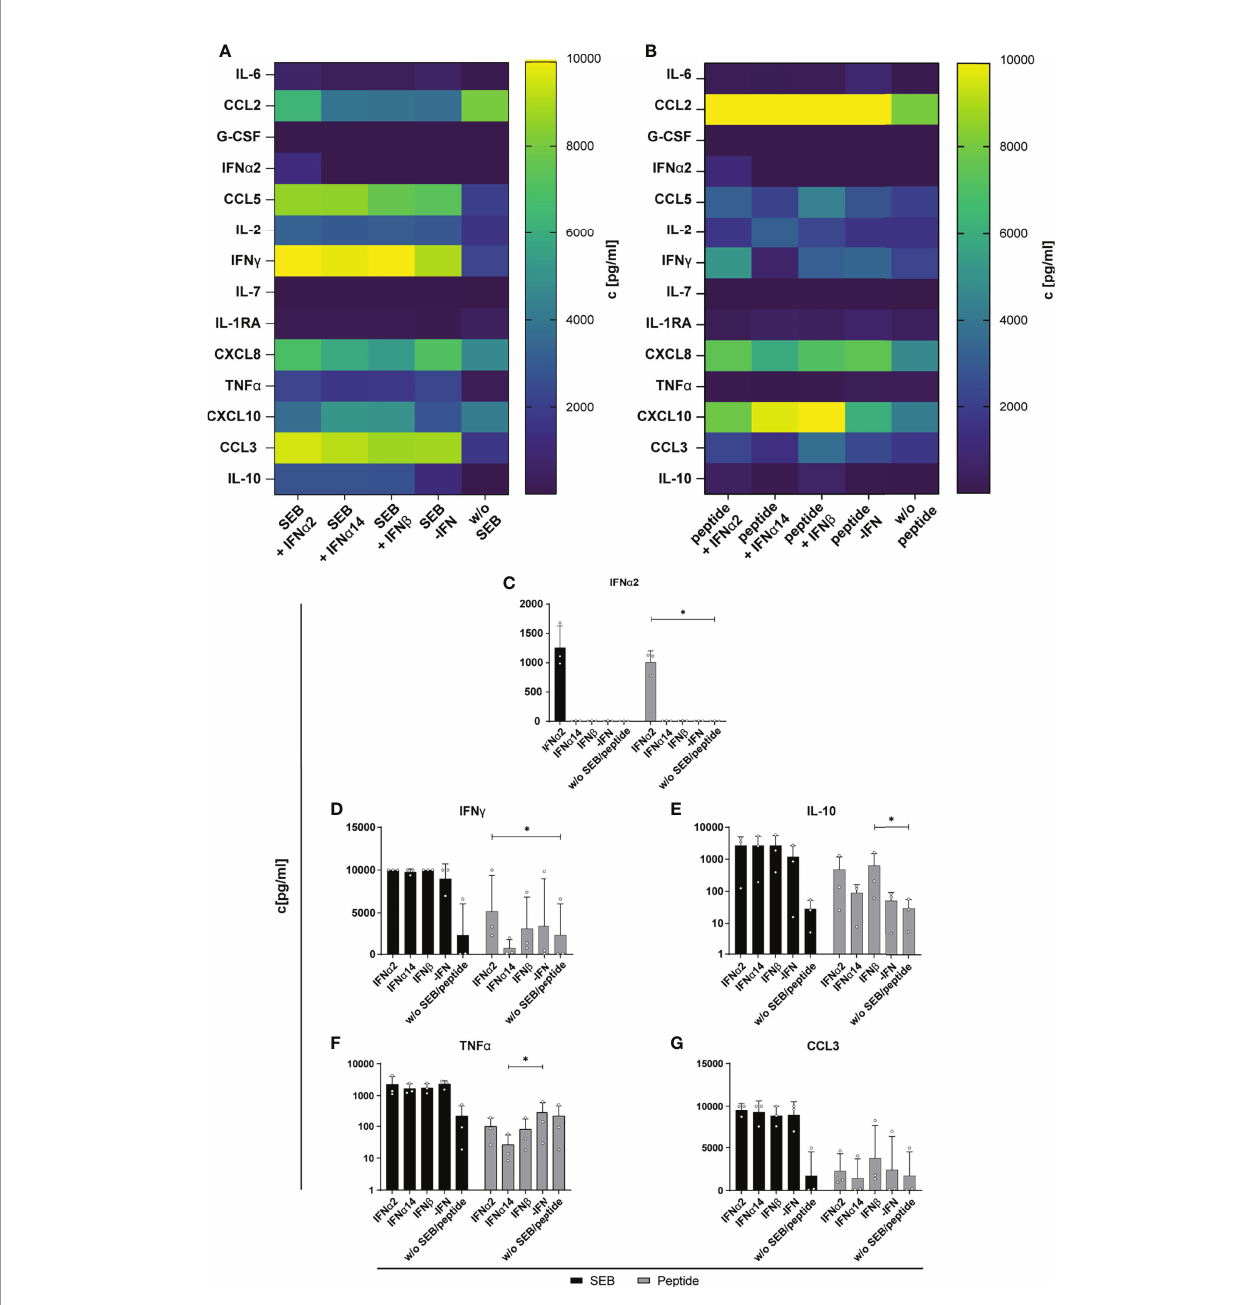
FIGURE 5 | Cytokine and chemokine pro fi le in supernatants of SEB and HIV peptide pool stimulated PBMCs from PLWH. PBMCs from cART-treated PLWH were stimulated as described in Figure 3 with SEB or HIV peptide pool and treated with either 2000 U/ml IFN a 2, IFN a 14, IFN b , or without IFN (-IFN). On day 4 supernatants were collected for multiplex bead-based assay to quantify cytokines and chemokines. (A) Heatmap of IL-6, CCL2, G-CSF, IFN a 2, CCL5, IL-2, IFN g , IL-7, IL-1RA, CXCL8, TNF a , CXCL10, CCL3, and IL-10 concentrations in pg/ml after stimulation with SEB or (B) HIV peptide pool. (C – G) Concentration of IFN a 2, IFN g , IL-10, TNF a , and CCL3 in supernatants of SEB or HIV peptide pool stimulated PBMCs from PLWH after different IFN treatment. Mean values ± SEM are shown for n=3. Statistical analyses between the treated groups within a cell population were done by Friedman test and Dunn ’ s multiple comparison test. *, P <